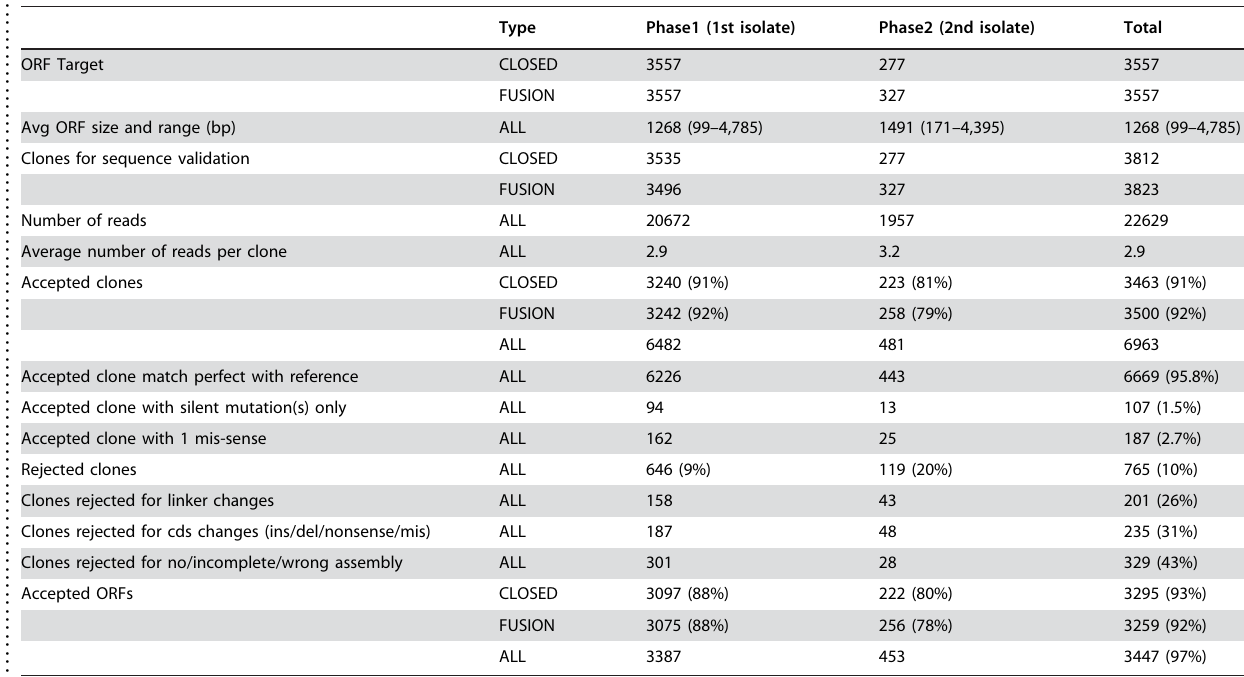
Table S2 Disease MeSH Term Analysis. Complete Analysis for Gene and Diseases Association in Publications Table S3 Biological and Chemical MeSH Class Analysis. Complete BioGene analysis of biological and chemical MeSH class associations with genes in PubMed, using either all human genes (2004), unique genes in MGC (2004), or HFLEX7000 (targets). Numerical values and percentiles of each class associated with genes are shown ( # , %). Relative MeSH Class associations in either MGC or HFLEX7000 to the genome, and in HFLEX7000 to MGC examine a potential bias in MGC or HFLEX7000 towards specific MeSH terms. Table S4 HFLEX7000 Clone List. Complete listing of all accepted, fully sequence validated ORF clones with Gene Symbol, Entrez GeneID, PlasmID CloneID, Clone GenBank Acc. No., Clone IMAGE ID, and Reference GenBank Acc.